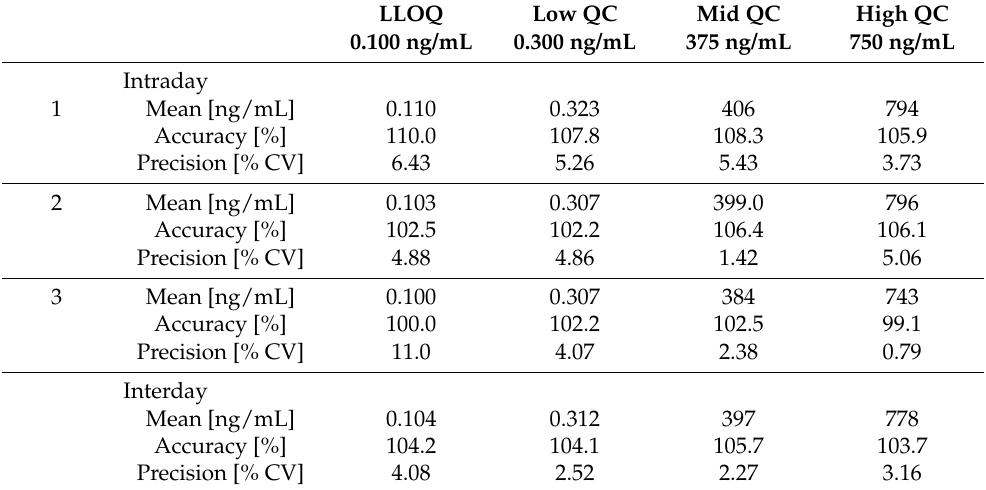
Table 2. Quality control results for functional LAT-1 HD